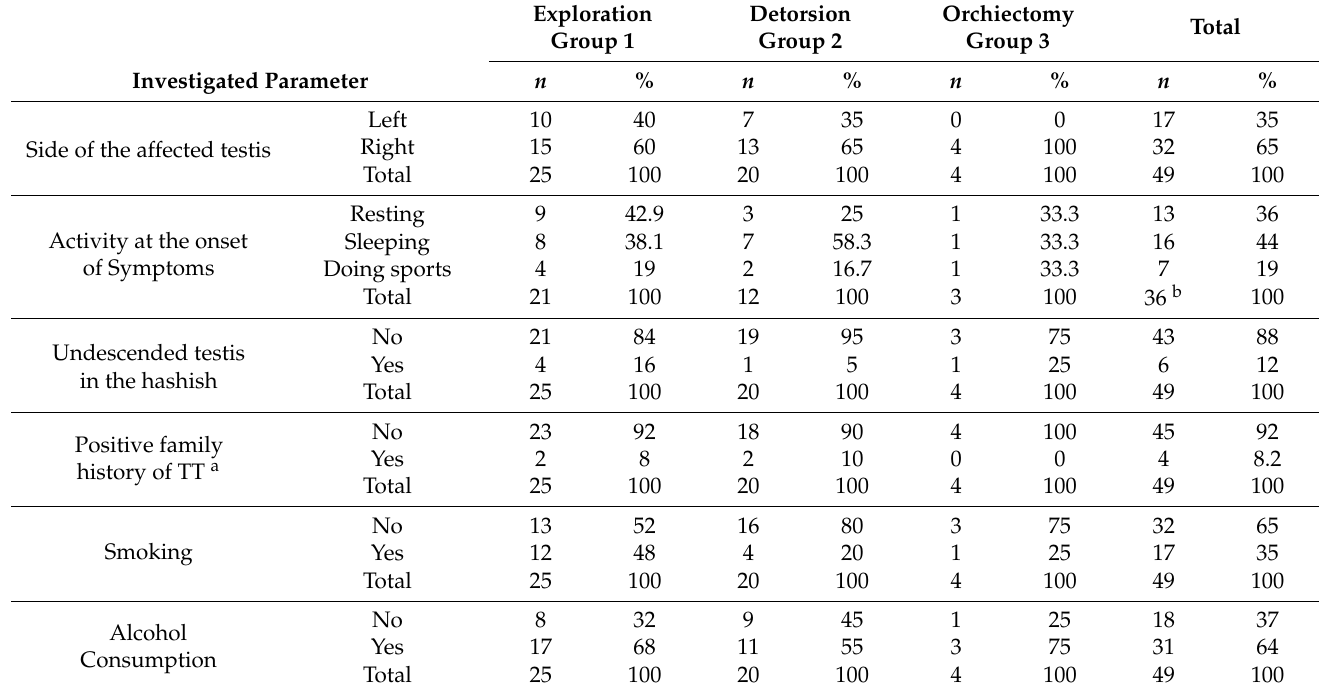
Table 1. Demographic data of